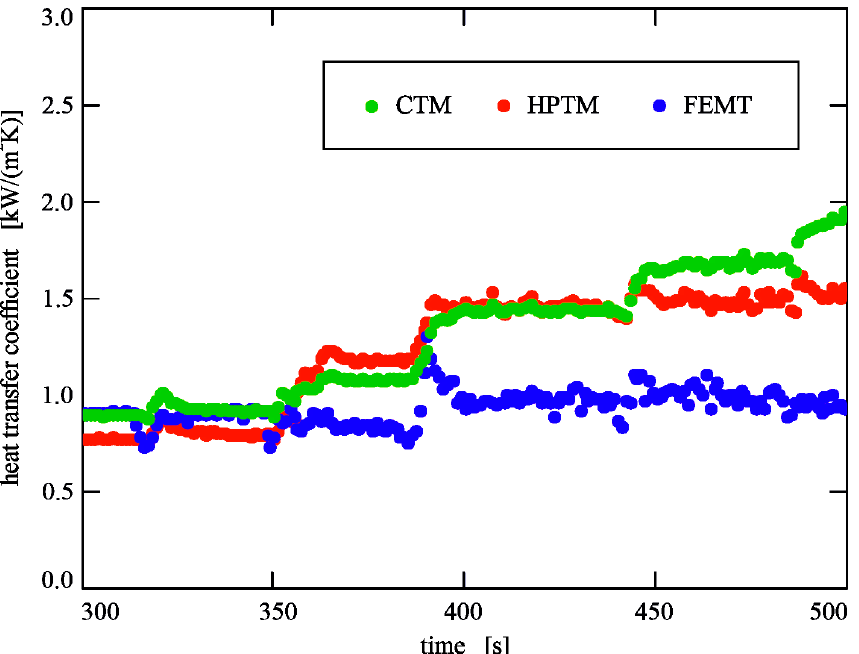
Figure 12. Heat transfer coefficient versus time, the distance from the mini-channel inlet x = 0.0242 m; other experimental parameters are listed in Table 1.